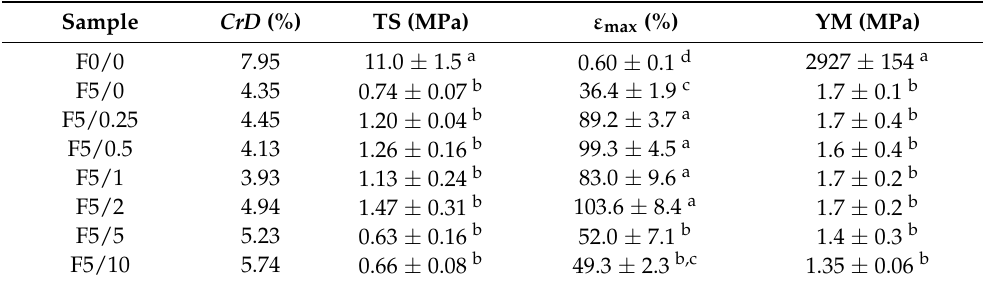
Table 2. Estimated crystallinity degree (CrD), tensile strength (TS), elongation at break ( ε max ) and Young’s modulus (YM) of CS-DES based